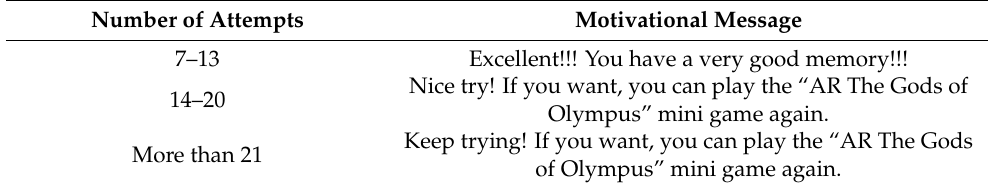
Table 2. Motivational messages in the “Memory game”.